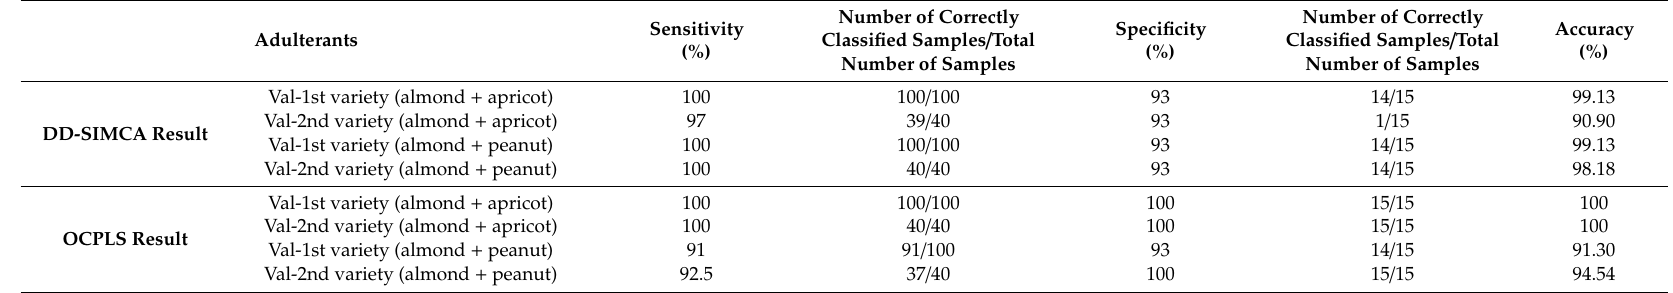
Table 3. Summary table of model performance obtained by applying OCPLS and DD-SIMCA to FT-NIR